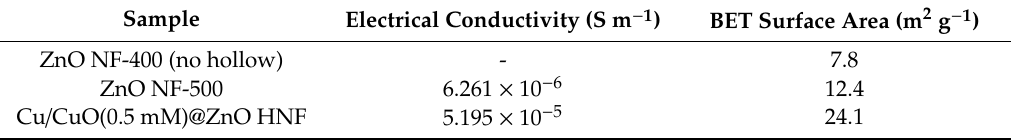
Table 3. Electrical conductivity and Brunauer–Emmett–Teller (BET) surface area of the